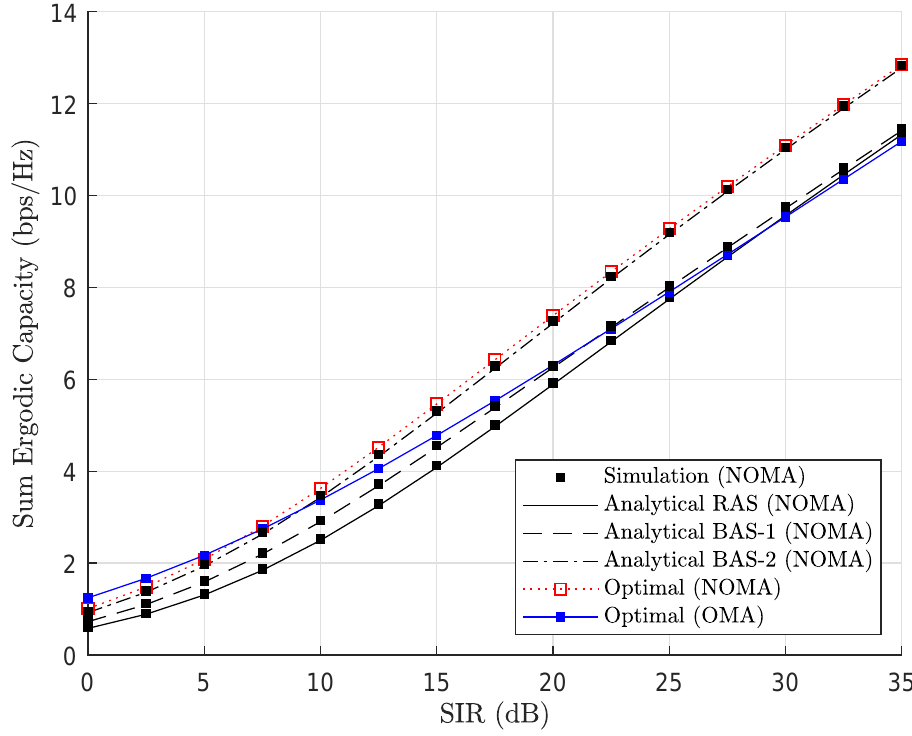
Figure 4. Sum Ergodic